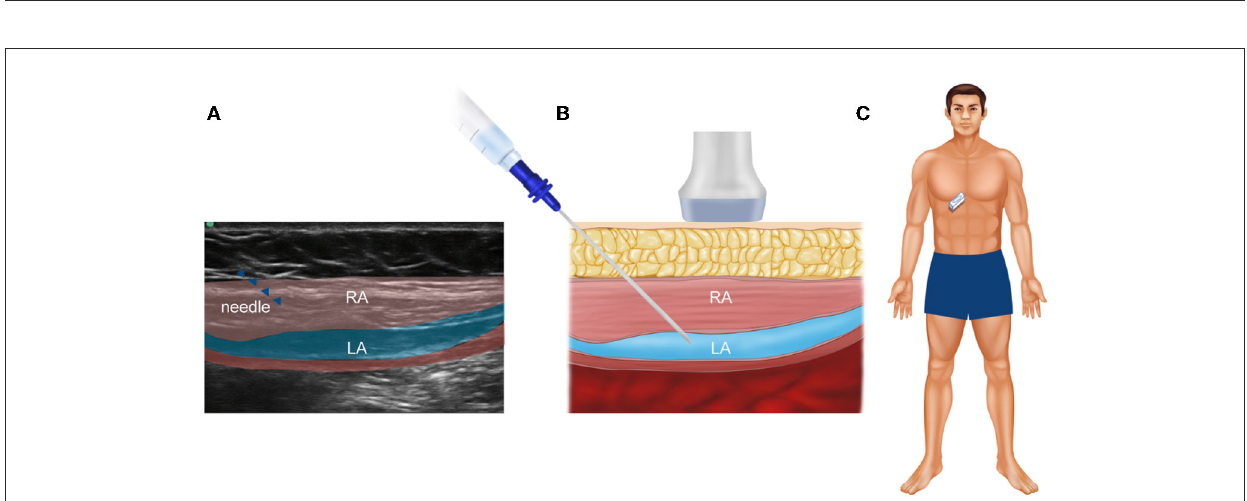
FIGURE2 An ultrasound of the abdominal muscles and fascia in the subcostal TAP. (A) Real ultrasound image of the patient; (B) the corresponding schematic view, which is used to show the injection site more clearly; (C) the specific position of the ultrasonic probe on the patient’s abdomen. RA, rectus abdominis; LA, local anesthetic.